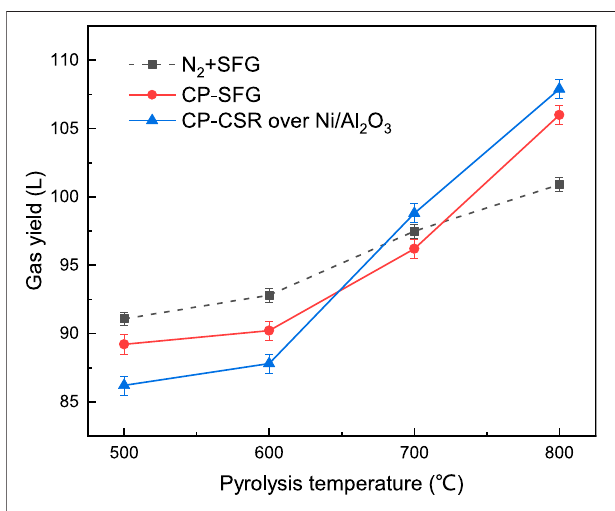
FIGURE 4 | Total gas volume produced under different atmosphere.